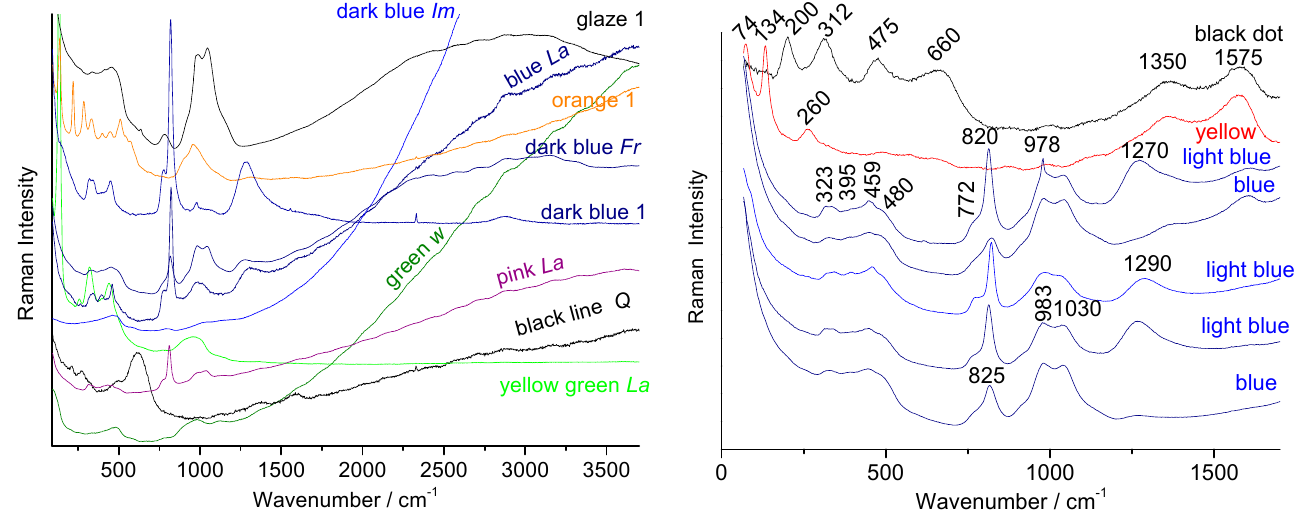
Figure 13. Raman spectra recorded on European (glaze 1, orange 1, dark blue 1), Chinese Famille rose (dark blue lm, blue La, dark blue Fr, black line Q, pink La, black line Q and yellow green La) and wucai plates (green w) for different colored enamels representative of the 18th century enameling recipes (see reference [23]). Details for Famille rose overglaze are given on the right. Note the variation of the Raman spectrum and fluorescence background of blue enamel with color density in the same area.